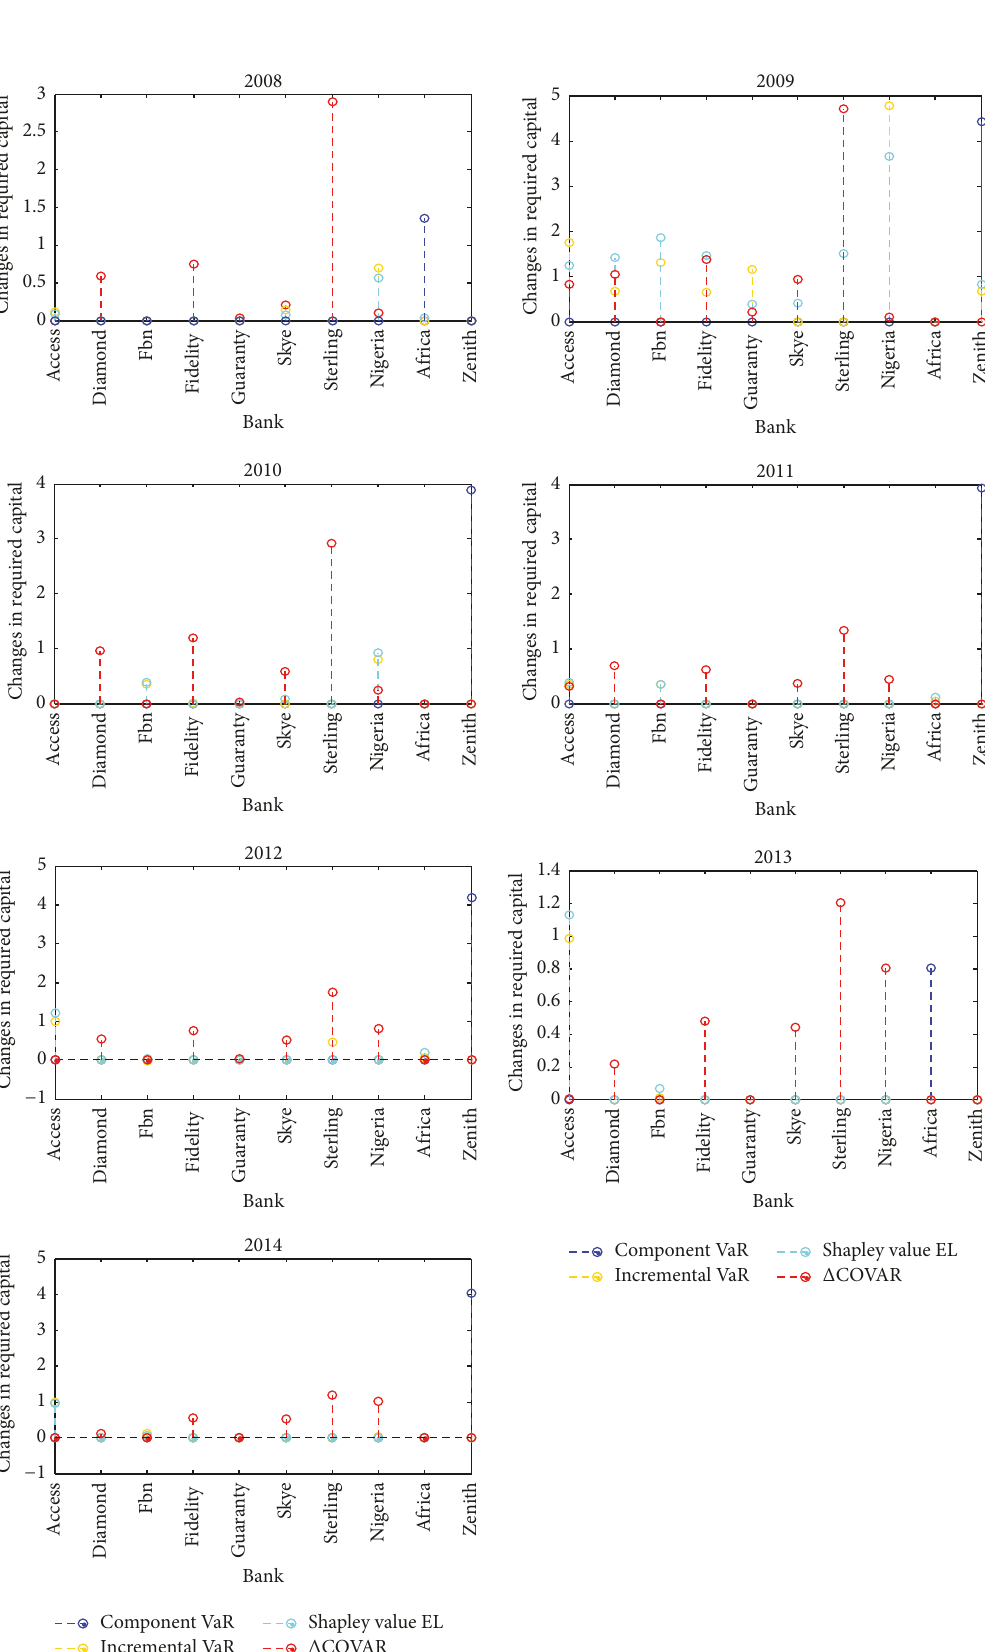
Figure 3: Increase in capital as a share of banks’ risk weighted assets using four risk allocation mechanisms assuming shocks